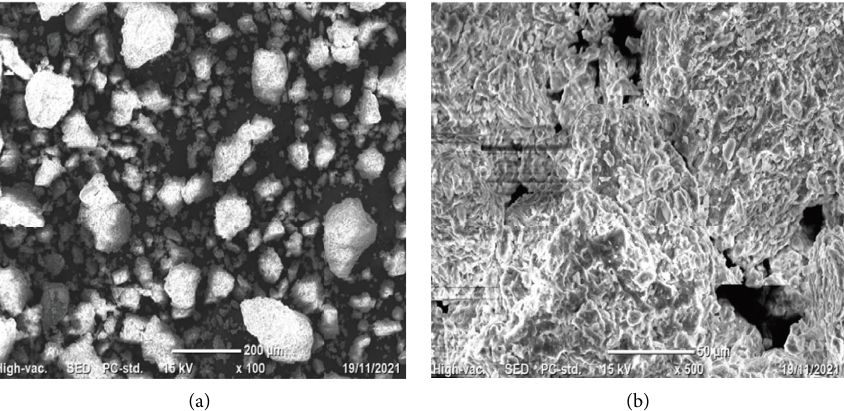
Figure 8: SEM picture of expansive soil containing 20% FA and 10%